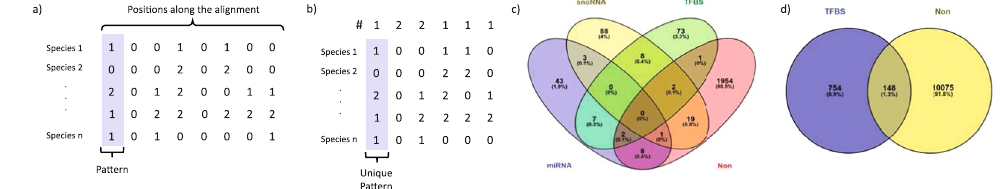
Figure 1. Data preparation. (a) Ternary representation of gene architectures within a set of orthologous transcripts. (b) The data from (a), represented by the unique patterns in the data and their number of occurrences. (c) Venn diagram showing the functions overlaps between functional and non-functional introns in Dataset 1. (d) Venn diagram showing the functions overlaps between functional and non-functional introns in Dataset 2. Venn diagrams were produced using Venny 43 .